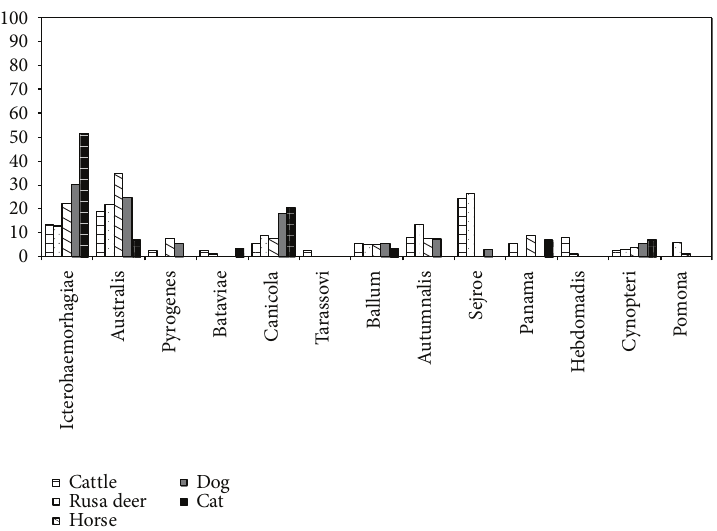
Figure 2: Distribution of different serogroups of pathogenic Leptospira species in ruminants, horse, and carnivores.